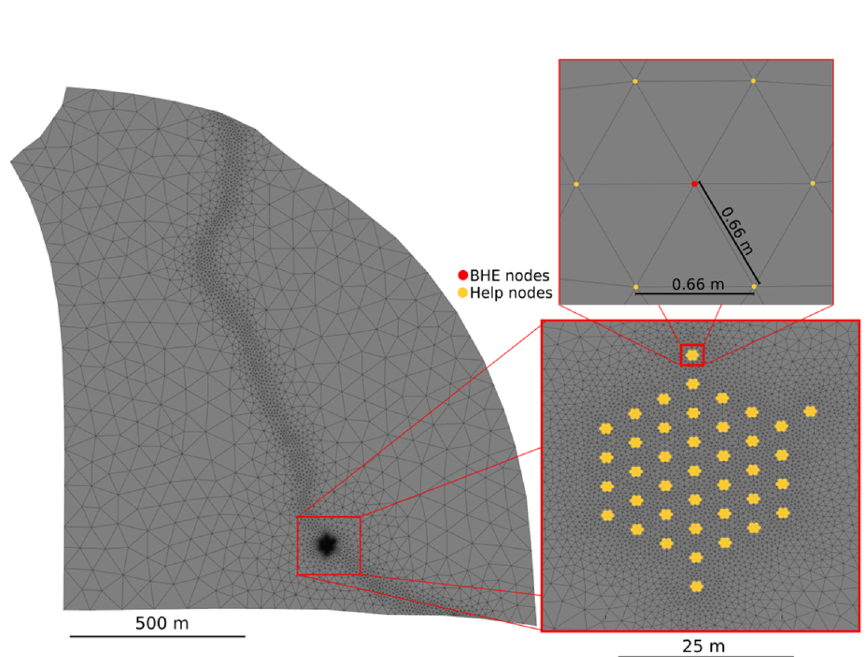
Fig. 6 Model domain with the integrated BHE and the discretization scheme around every BHE